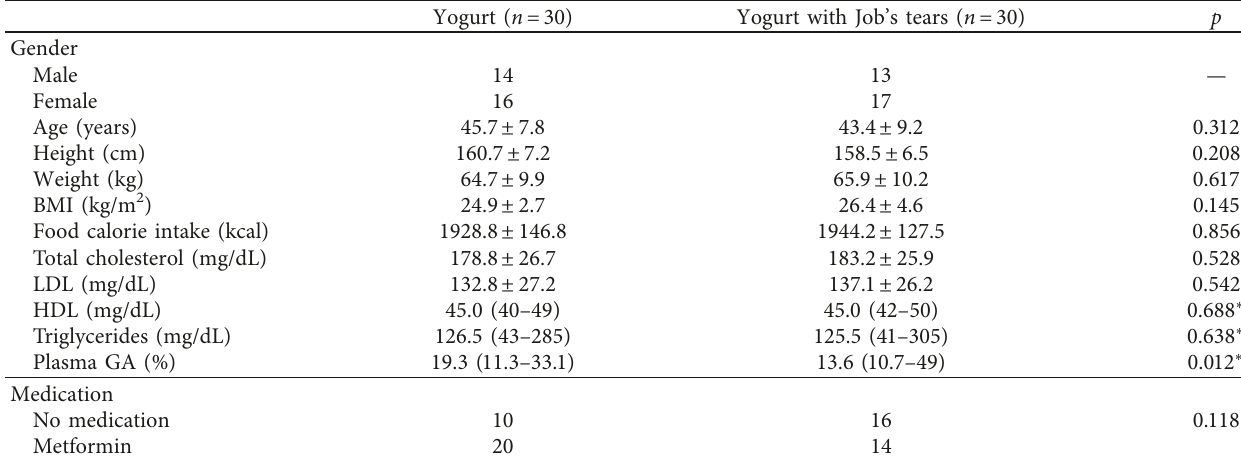
Table 1: Characteristics of